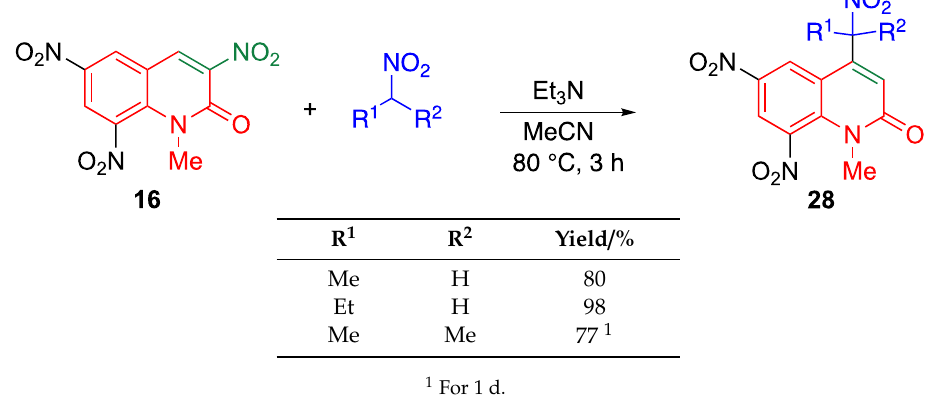
Table 8. cine -Substitution of 16 with nitroalkanes.